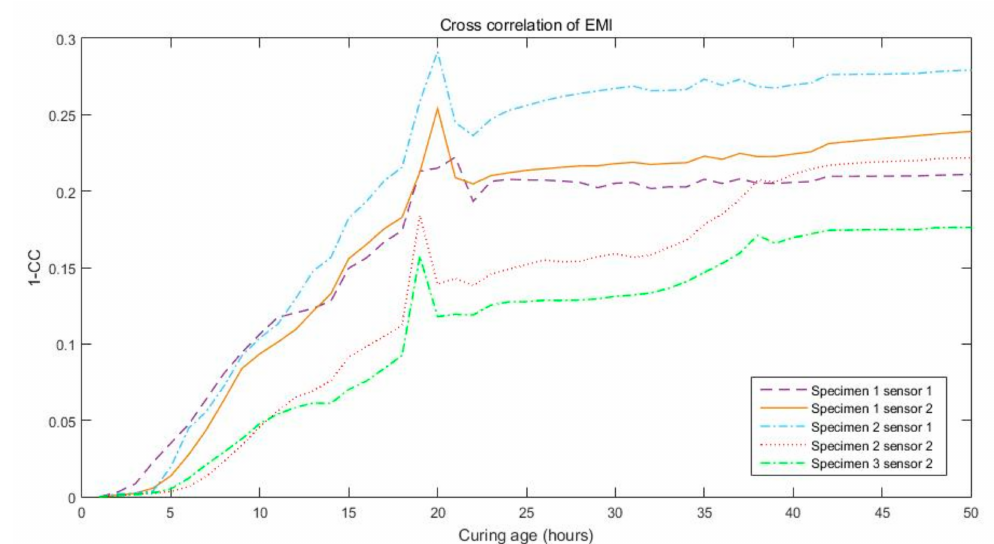
Figure 6. Cross correlation (CC) of impedance data observed by five channels for 48 h.